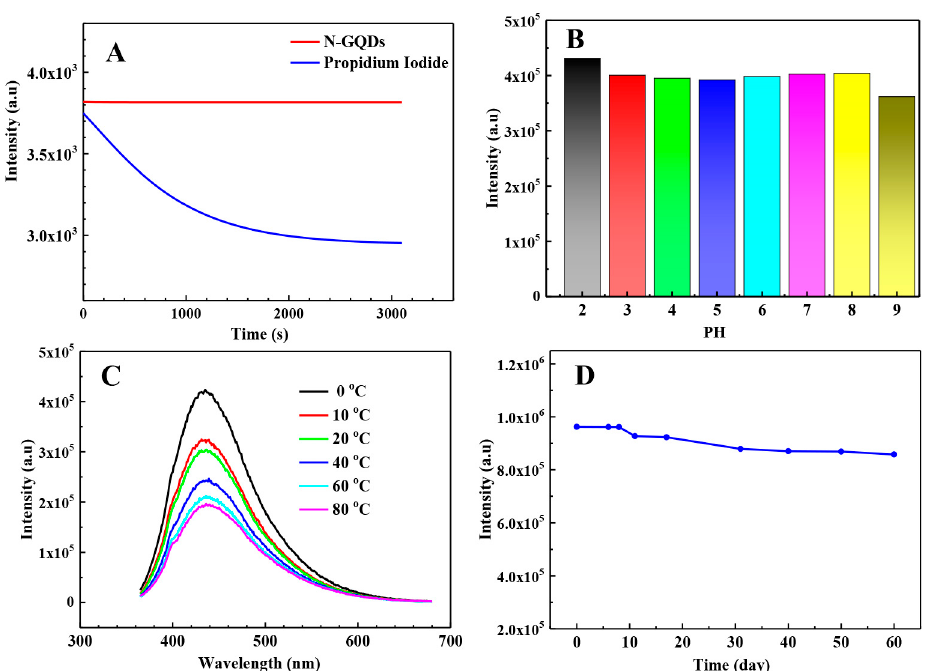
Figure 5. The photo-stability of the N-GQDs. ( A ) The photo-bleaching resistance of the N-GQDs and the traditional dye of propidium iodide; the PL peak intensities varying with ( B ) pH and ( C ) temperature; and ( D ) the PL peak intensities over 2 months.